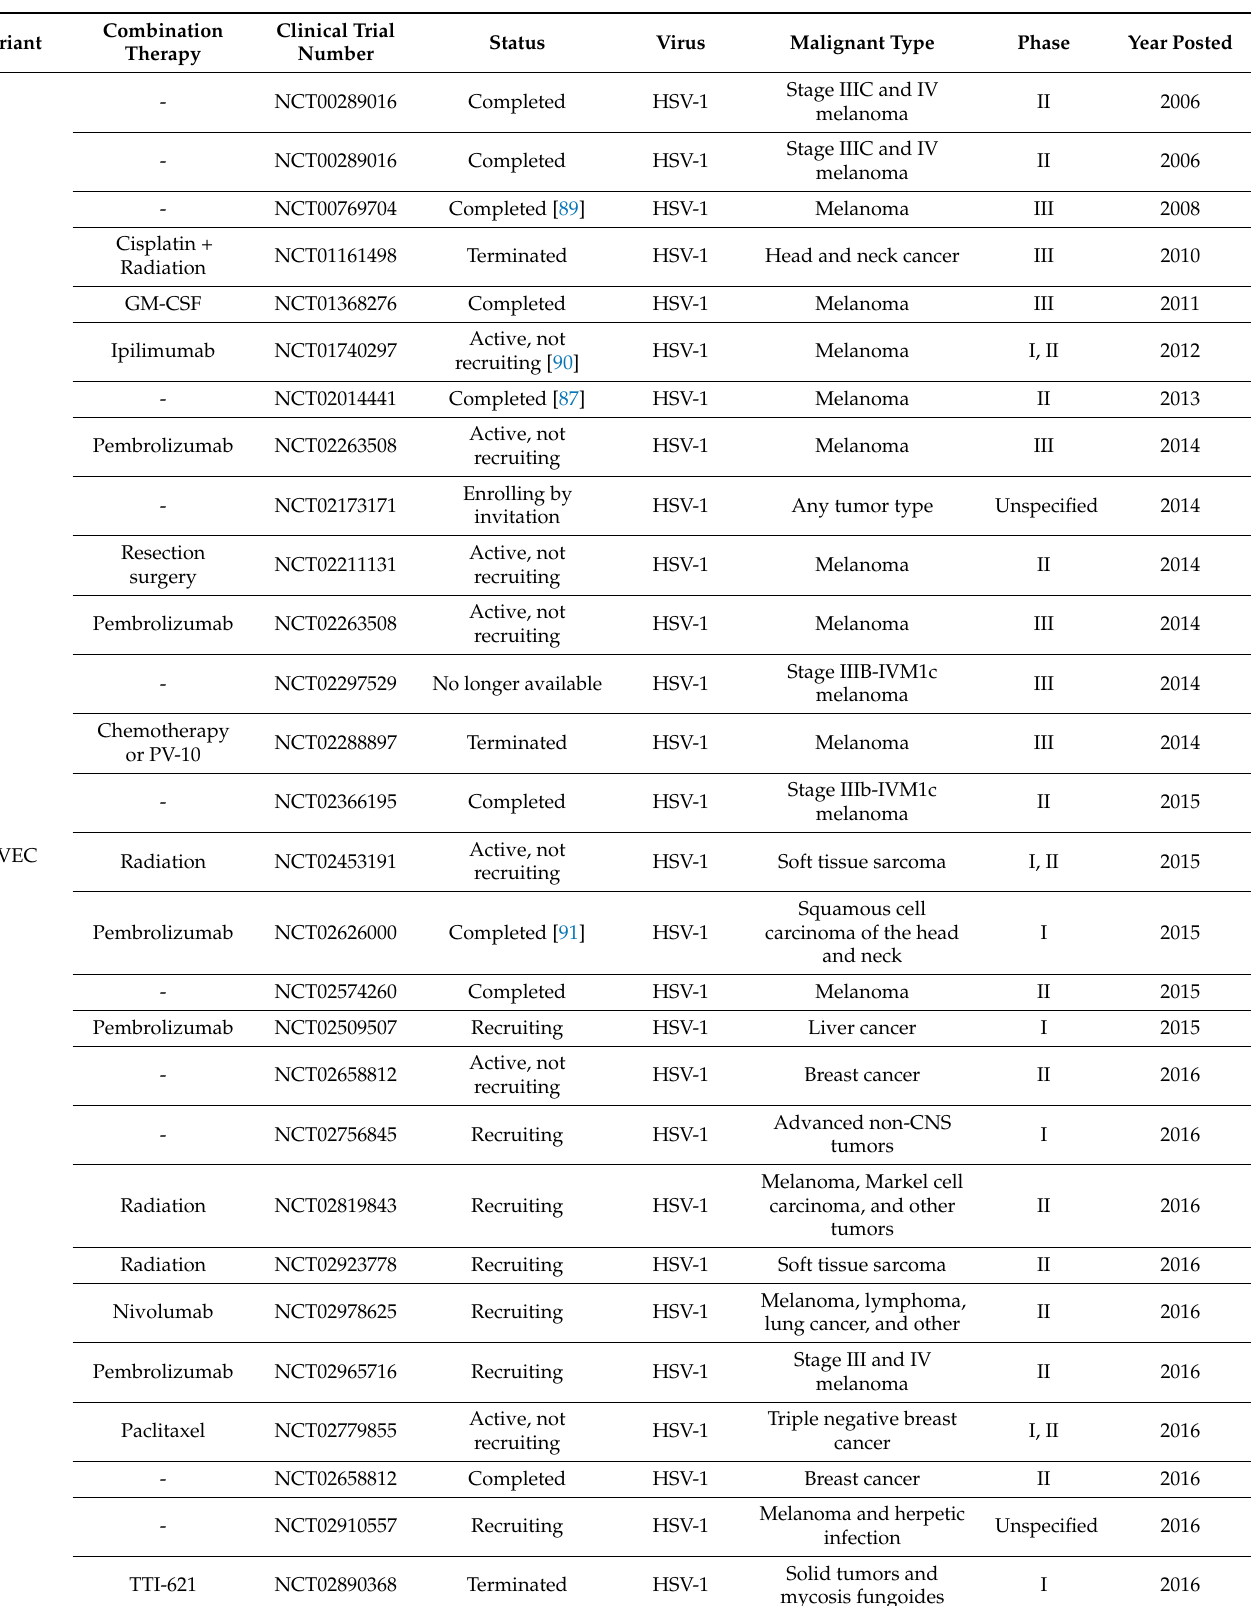
Table 2. A summary of clinical trials registered at ClinicalTrials.gov involving oHSV variants. Access date: 13 February